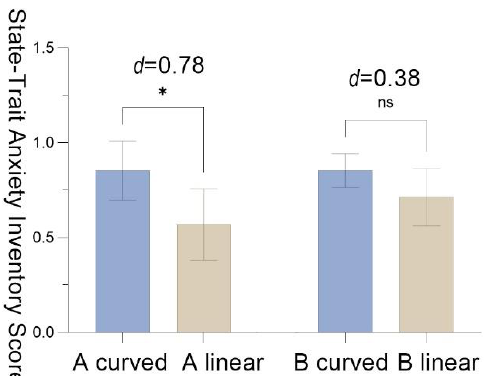
Figure 9. The results of the State-Trait Anxiety Inventory (STAI) score with the standard error mean bars; significance levels: ns p > 0.05, * p < 0.05; effect size (d): negligible (<0.2), small (0.2–0.5), moderate (0.5–0.8), and large effect (>0.8).